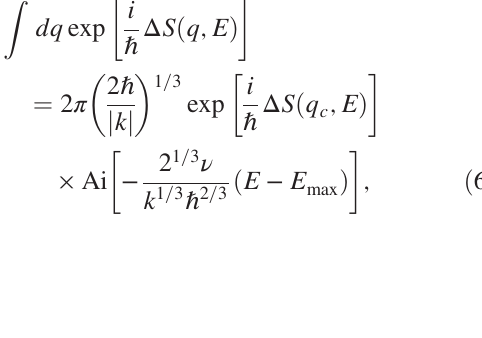
We suppress the subscripts b and b 0 , and we explicitly indicate that S B and p B depend on the final energy shell E .